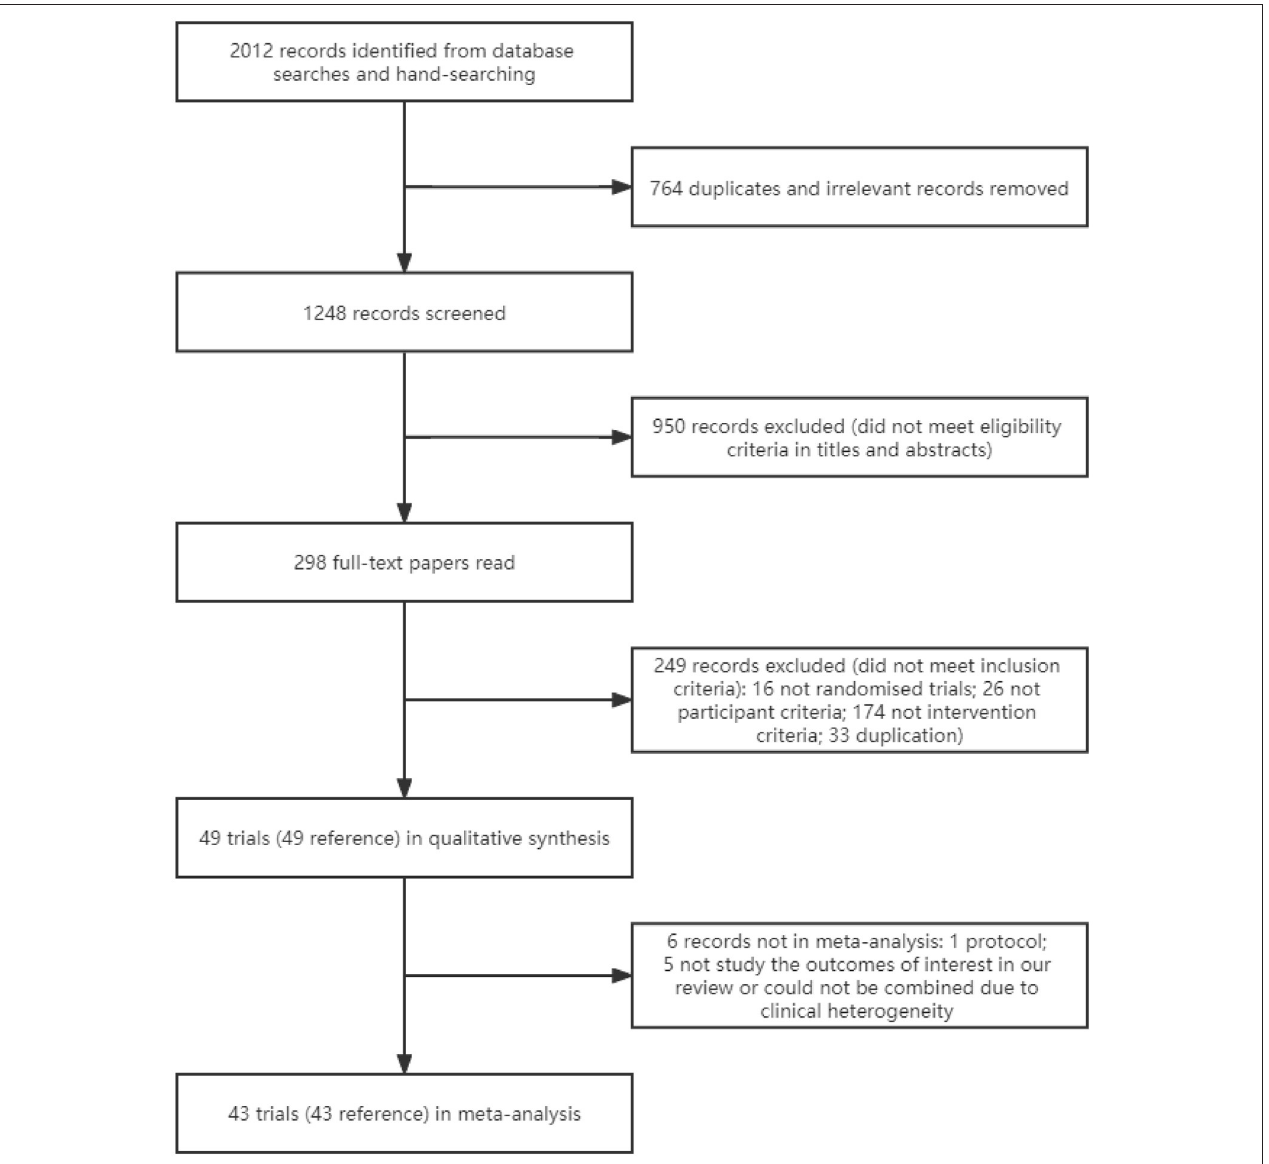
FIGURE 1 | Flow chart of included studies in this systematic